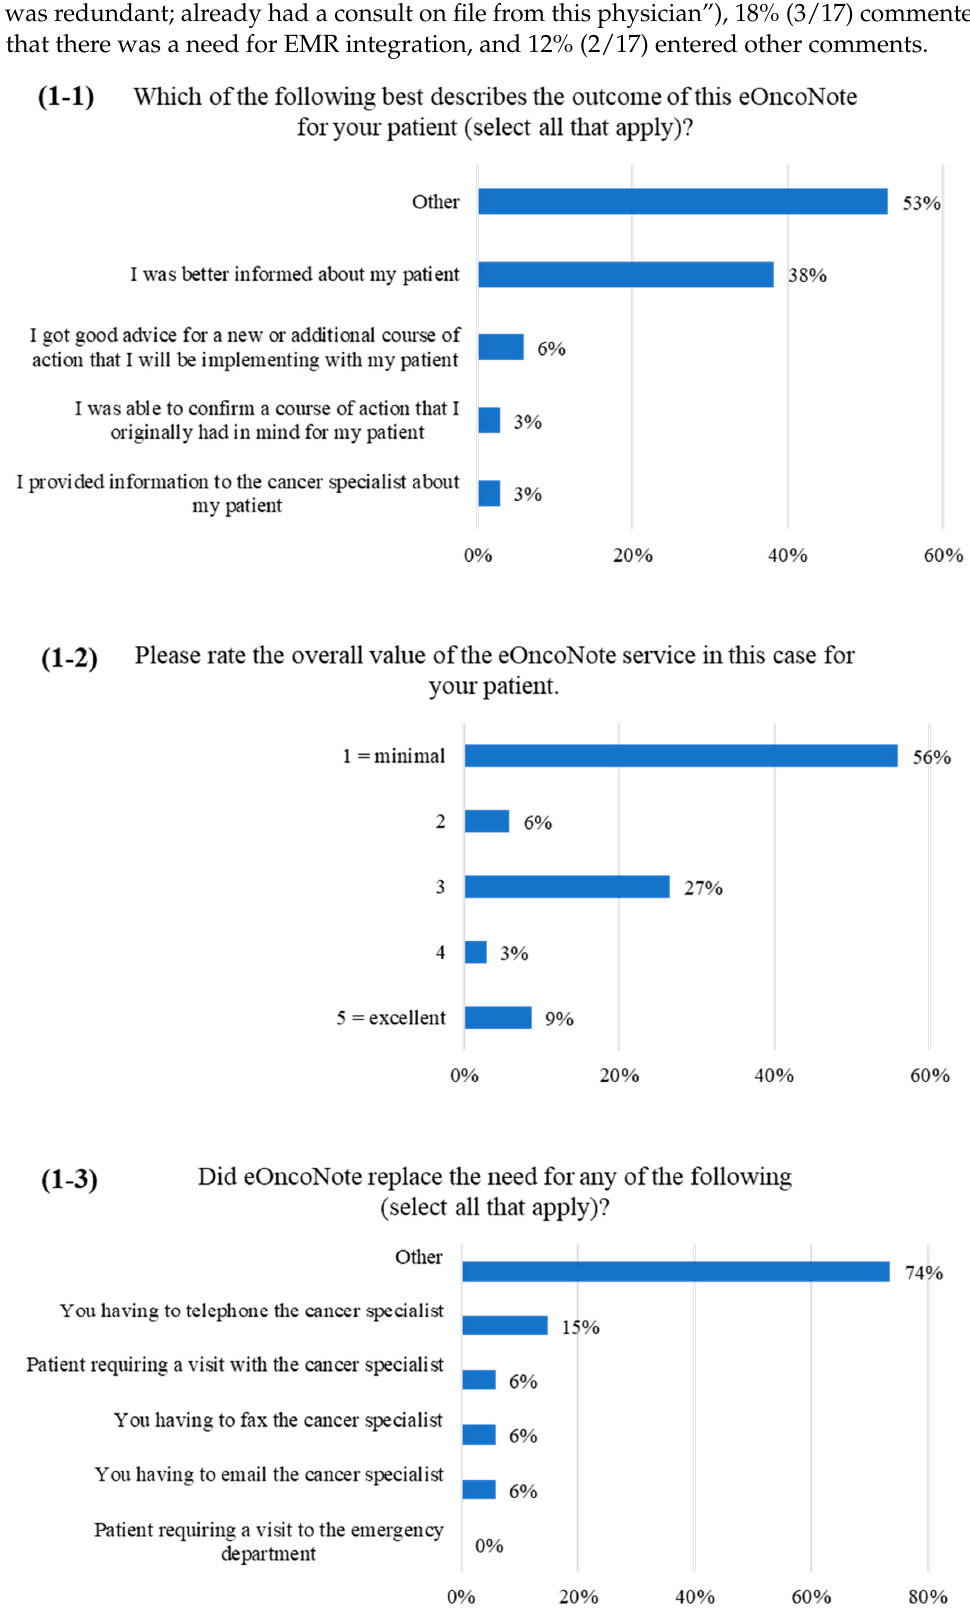
Figure 1. PCP survey responses (( 1-1 – 1-3) correspond to items 1, 2 and 3 on the survey, respec- tively).